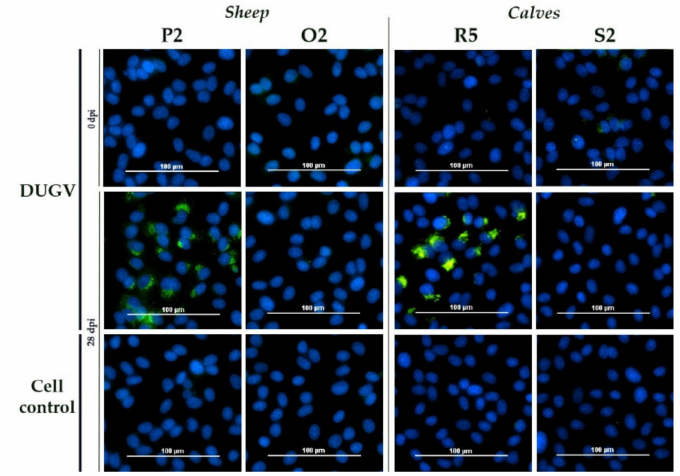
Figure 2. DUGV iIFA: The serum of sheep P2 (NSDV) and calf R5 (NSDV) led to a specific staining of DUGV-infected Vero E6, whereas the mock controls (sheep O2, calf S2) did not test positive. No non-specific signal was detected for pre-challenge serum.